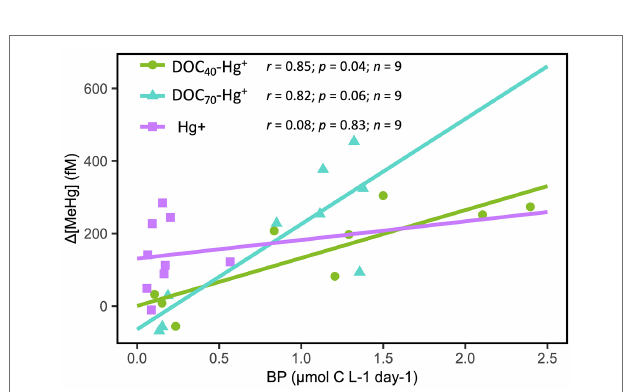
FIGURE 2 | Increment of methylmercury ( Δ MeHg) concentration over the unexposed control throughout the experiments in the treatments with addition of Hg(II). Δ [MeHg] = Value (treatment) − Value (Control) . The dashed line indicates the addition of Hg(II). Error bars represent the standard error ( n = 3).